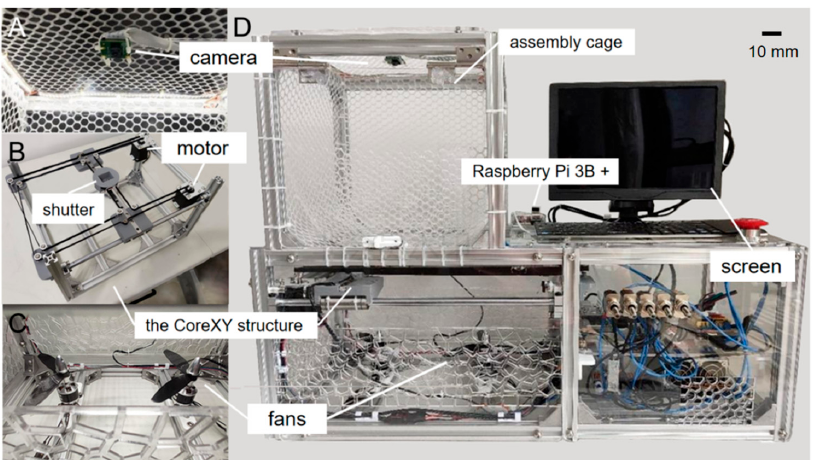
Figure 1. The molds and the structure of a tetrahedron. ( A ) The tetrahedral molds with locational holes for the magnets. ( B ) The ideal assembled tetrahedron structure is similar to the methane mol- ecule.